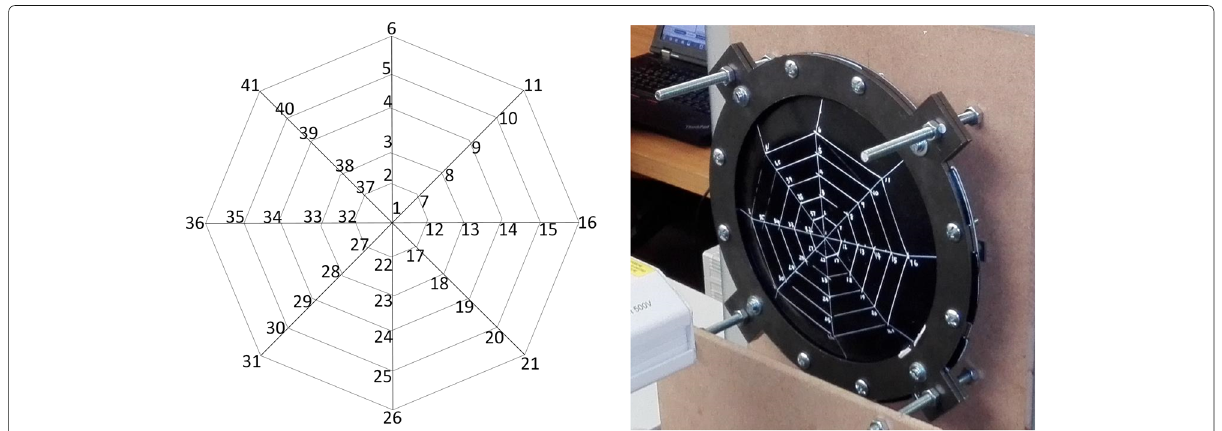
Fig. 11 Circular grid pattern and measurement points on the rubber sheeting